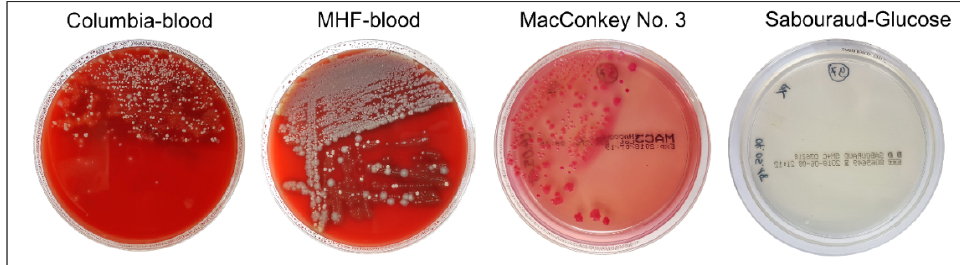
Figure 2. Cultivation of microorganisms from murine feces. Representative pictures of the heterogeneously overgrown Columbia and MHF blood agar (microaerobic, 37 °C), MacConkey No. 3 agar (aerobic, 37 °C), as well as the non-overgrown Sabouraud glucose agar (aerobic, room temperature) used to isolate individual bacterial species. From these and similar plates, colonies of different phenotypes were cultured in pure culture, isolated, and then identified by matrix-assisted laser desorption/ionization-time of flight (MALDI-TOF) mass spectrometry.